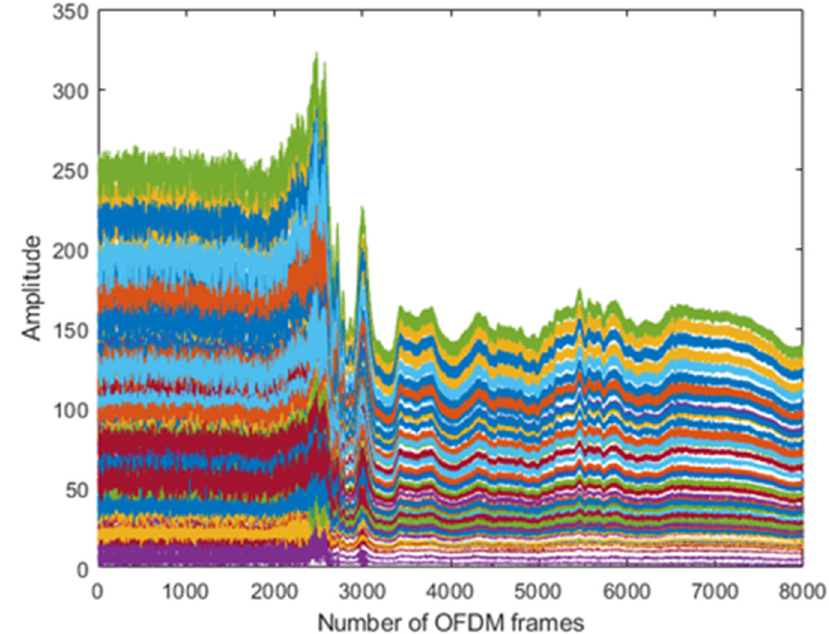
Figure 6. WCSI amplitude response of bending activity experiment.